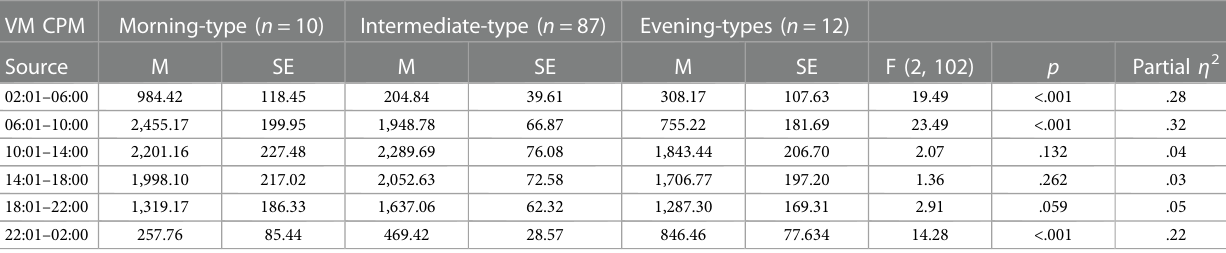
TABLE 6 Chronotype group differences in total activity within six 4-hour intervals ( N =109).